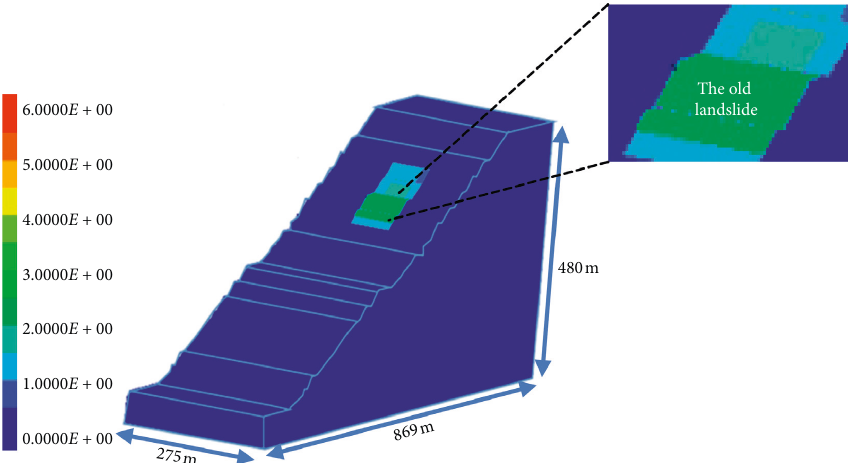
Figure 24: Displacement contour after landslide